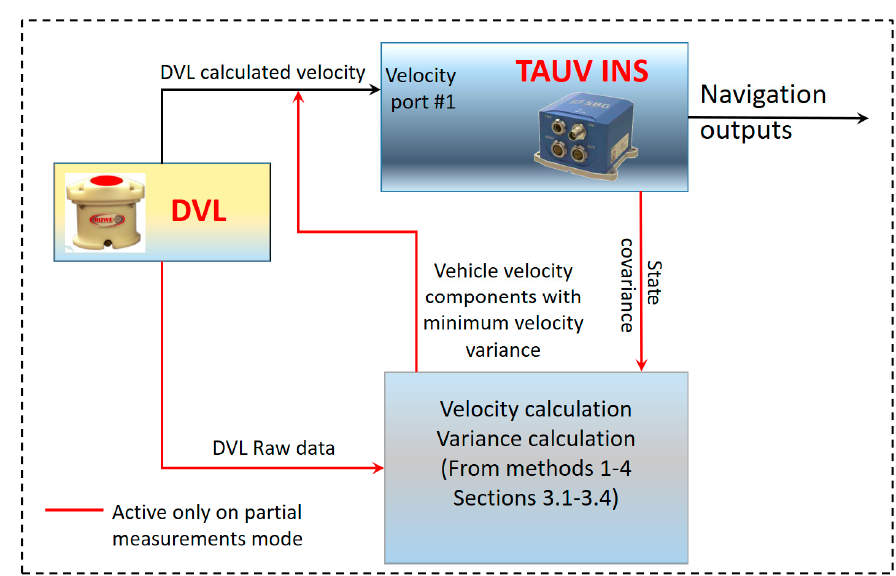
Figure 7 . Block diagram for implementation of ELC approach in the TAUV navigation system.